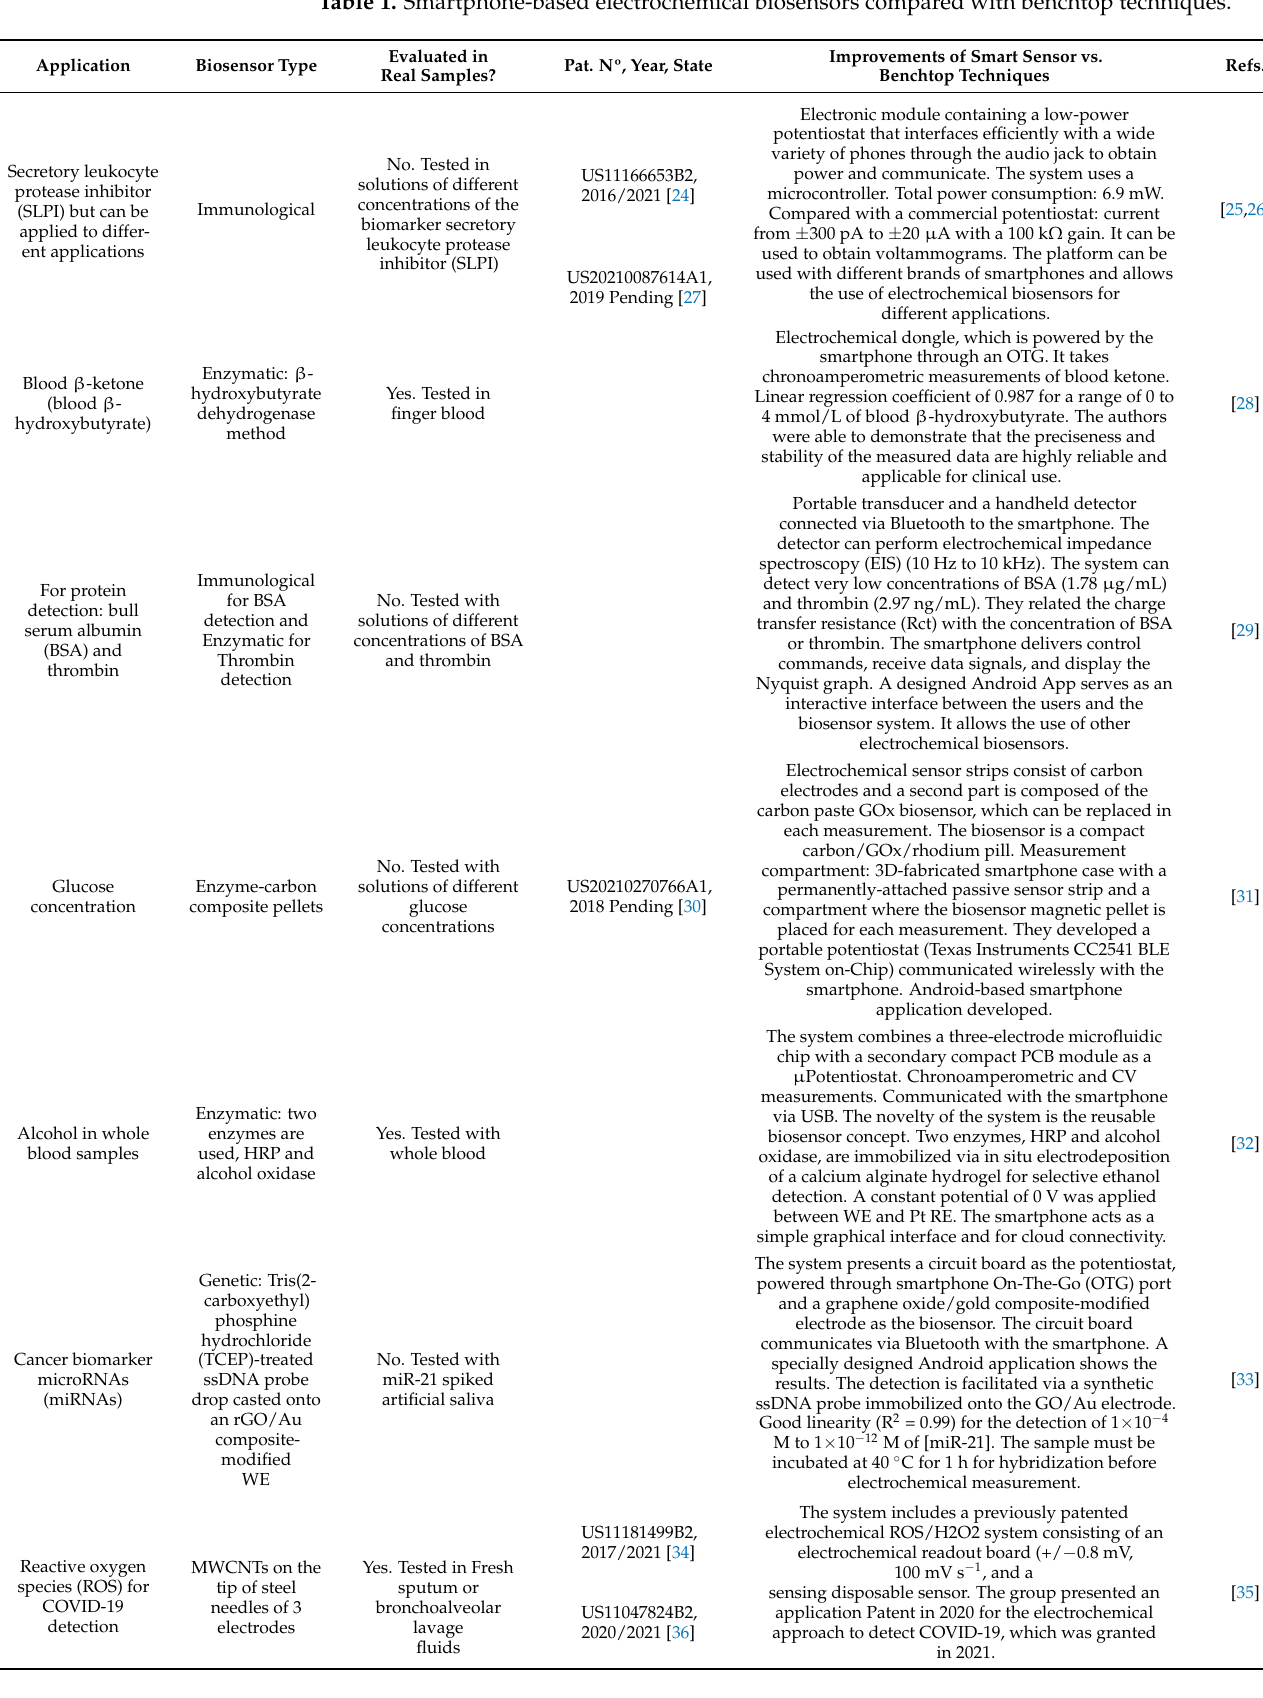
Table 1. Smartphone-based electrochemical biosensors compared with benchtop